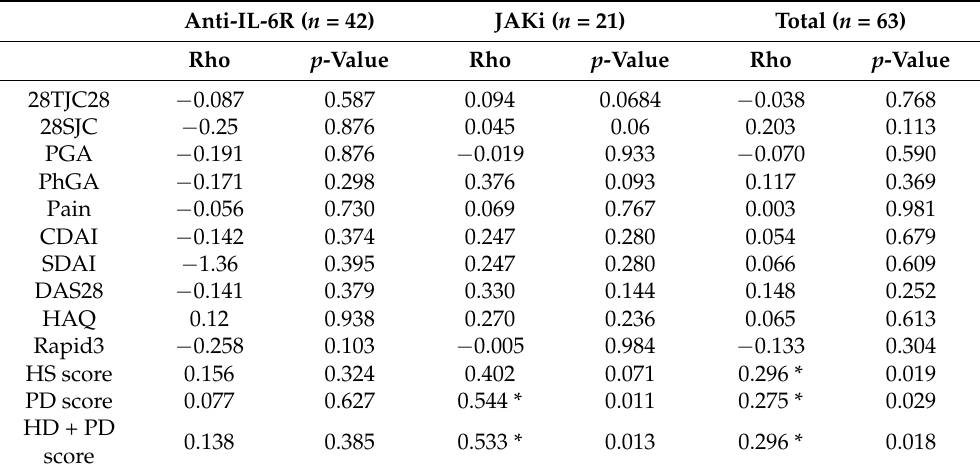
Table 3. Correlation between hsCRP and clinical and ultrasound disease activity.